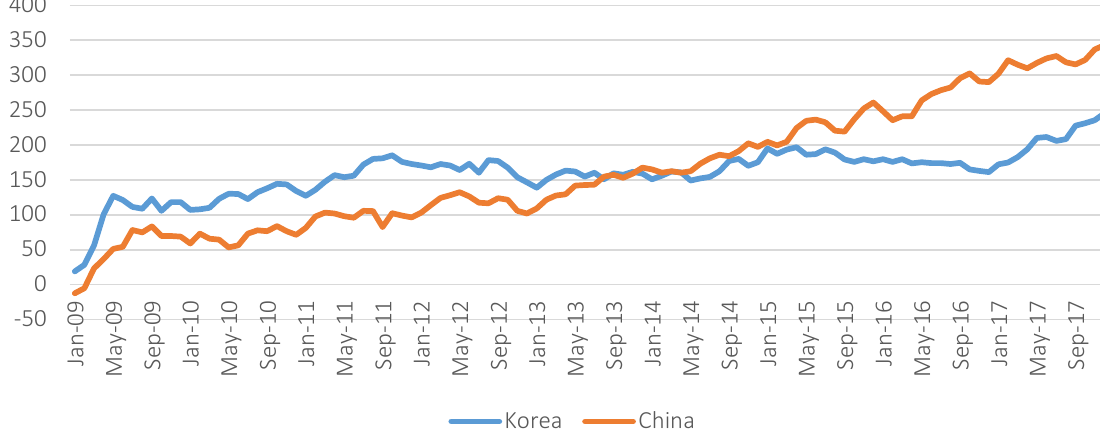
Figure 4. Cumulative returns for Korean and Chinese game industry